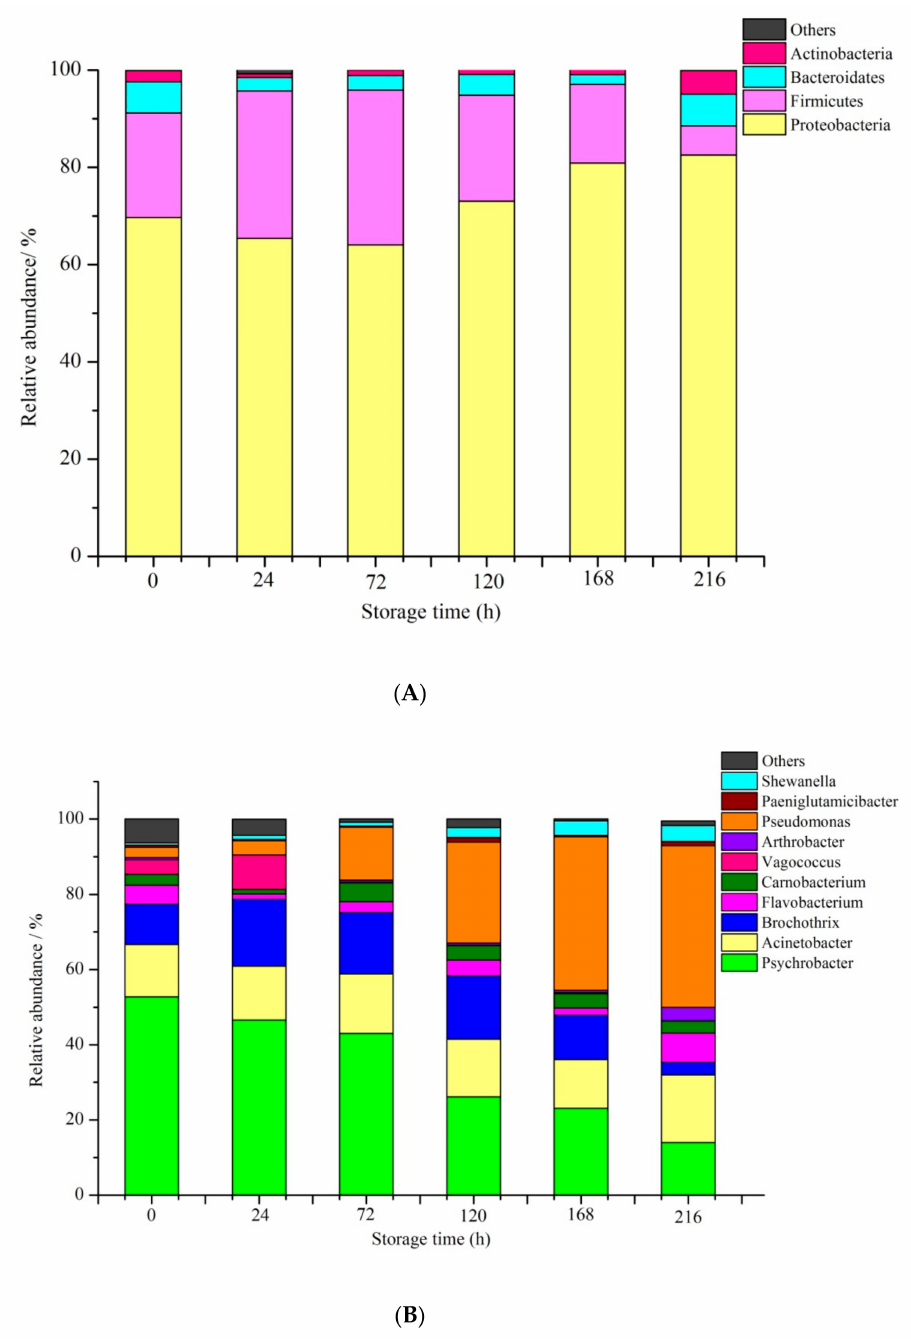
Figure 5. Relative abundance of the microorganisms in di ff erent Spanish mackerel samples—( A ) bacterial composition at phylum level; ( B ) bacterial composition at genus